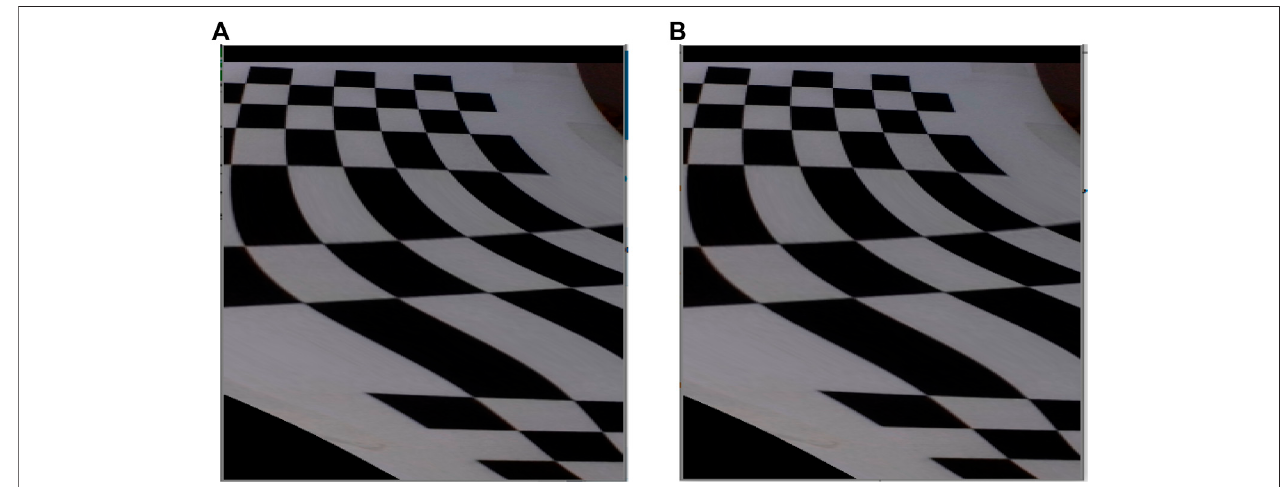
FIGURE 3 | Calibration examples. (A) Un-distorted image with 10 samples. (B) Un-distorted image with 20 samples.